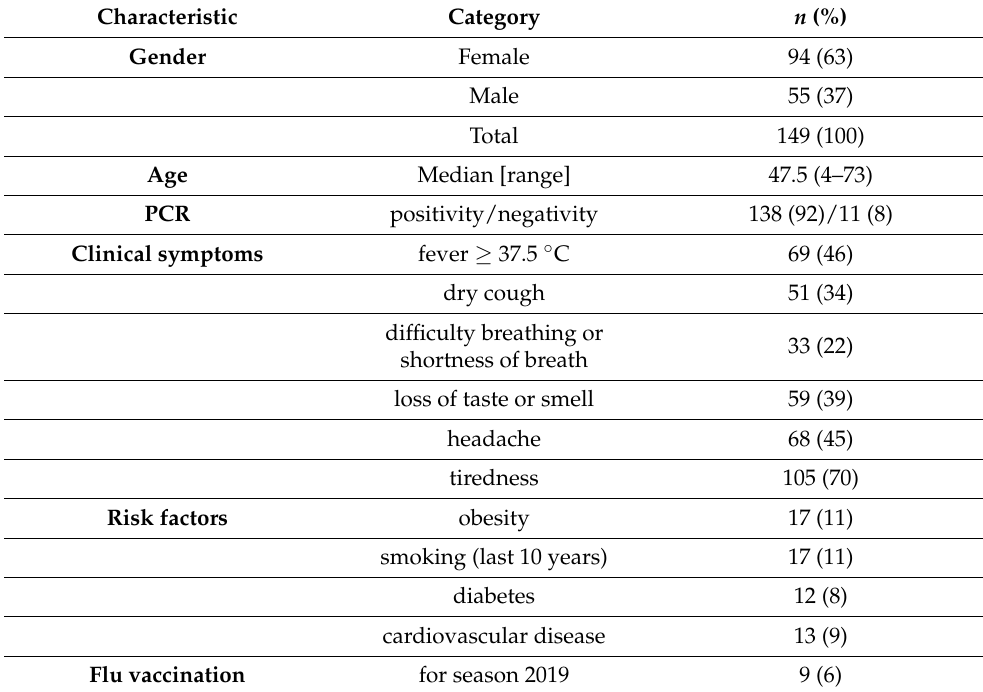
Table 1. Clinical characteristics of the patient group.